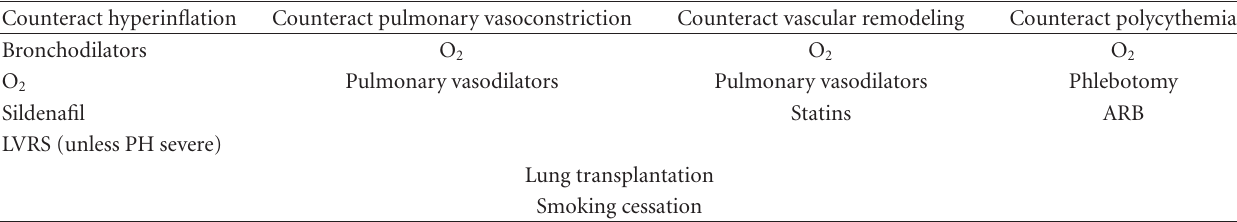
Table 4: Various approaches to the treatment of PH in COPD.